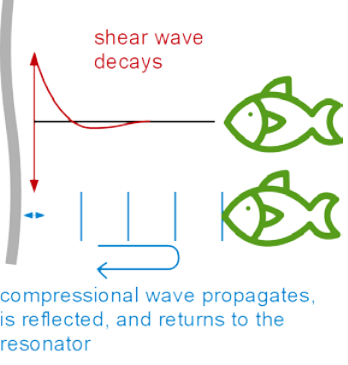
Figure 13. When shear waves dominate the resonator’s response, the QCM response is surface- specific. Flexural admixtures to the mode of vibration and the concomitant compressional waves may spoil surface specificity. Compressional waves may be reflected somewhere in the bulk and return to the crystal.